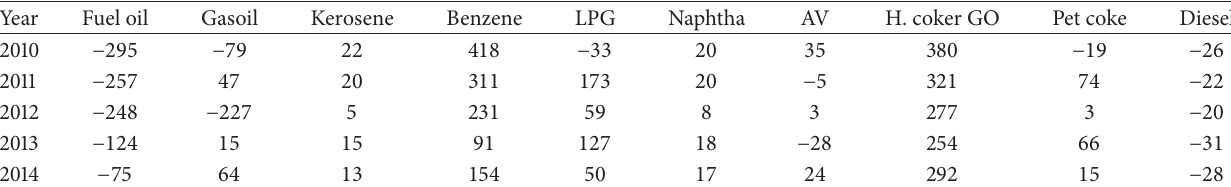
Table 15: Supply and demand balance (000 tonnes) [6].